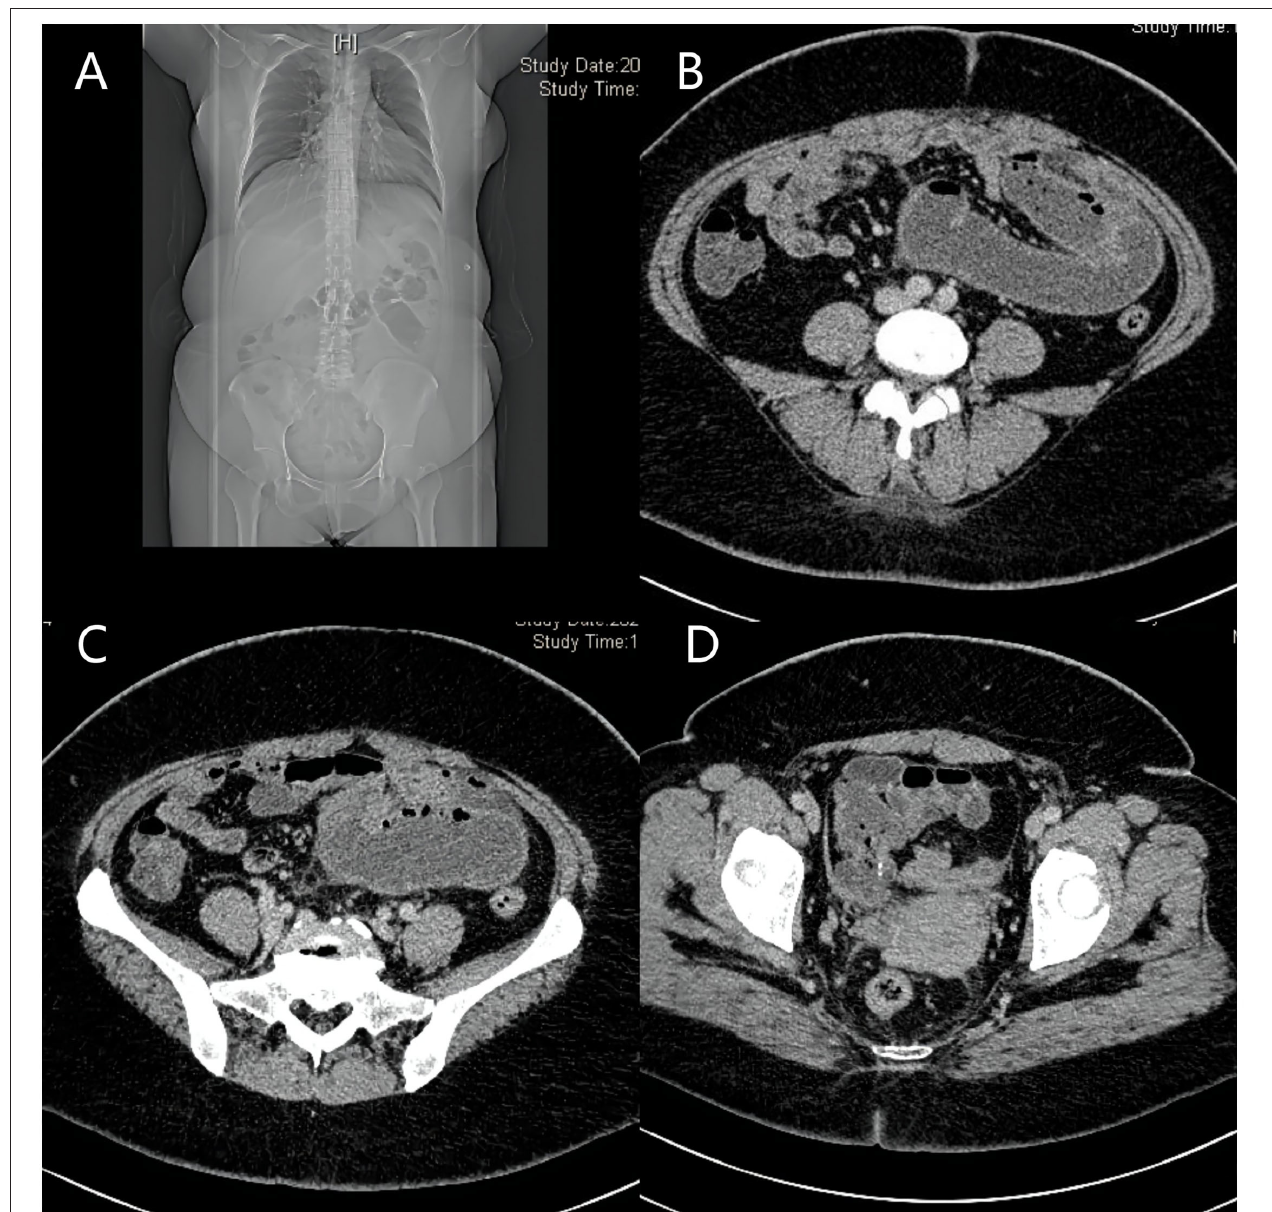
FIGURE 1 | Images of abdomen CT. (A–C) show intestinal obstruction, which possibly caused by torsion of adhesions; (D) : part of the small intestine is wrapped by a fibrous tissue membrane and folded into a mass.